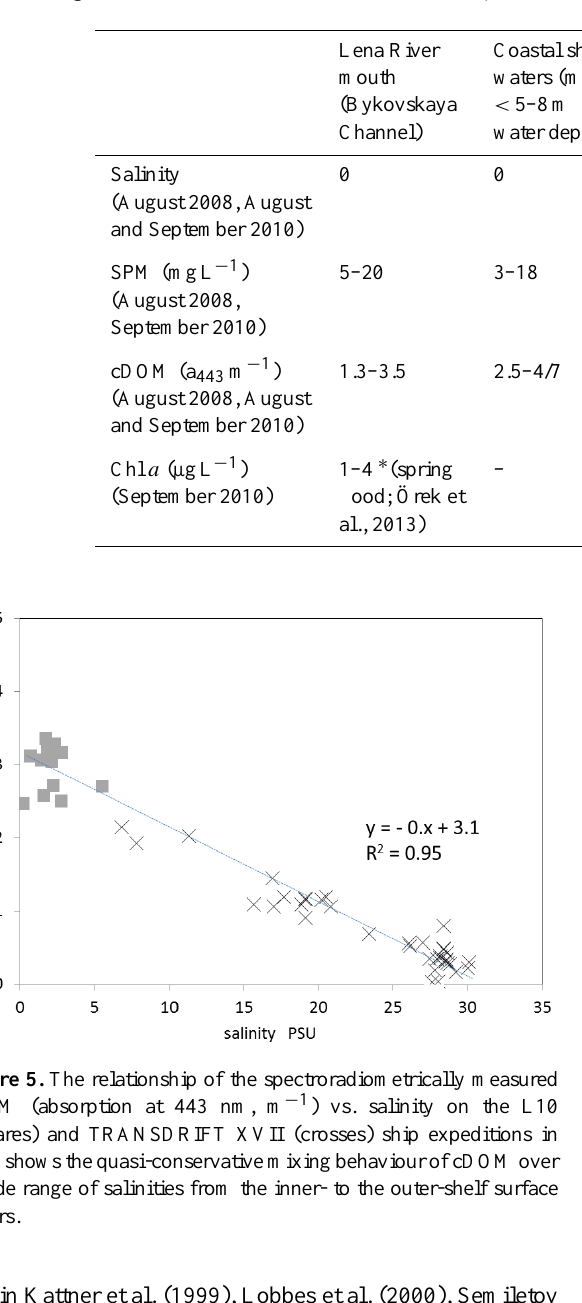
Table 2. Ranges of in situ measured variables (LENA2008, LENA2010, TRANSDRIFT) for different hydrogeographical regions.